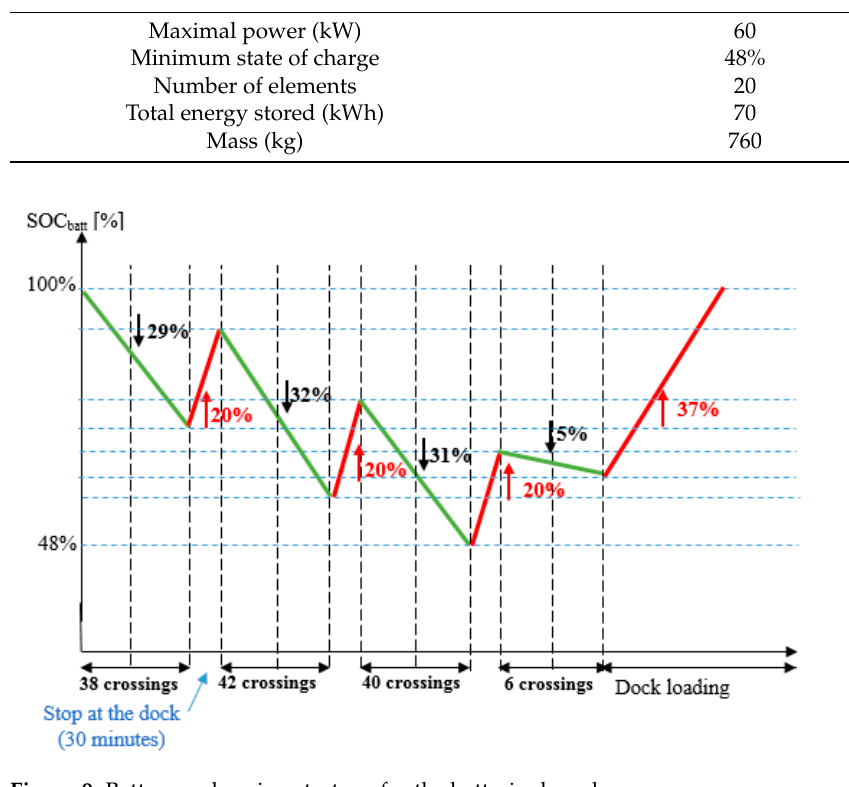
Table 5. Results of the battery sizing.